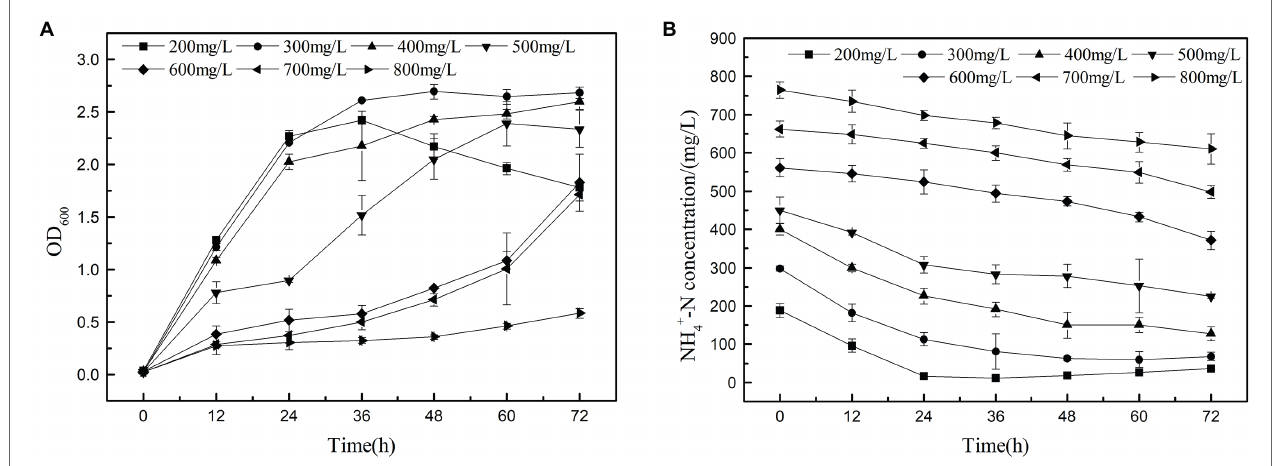
FIGURE 8 | Nitrification performance of strain K17 cultured under different ammonia nitrogen conditions. The initial ammonia nitrogen concentration was 200, 300, 400, 500, 600, 700 and 800 mg/l. The mixture was cultured at 165 rpm and 30 ° C for 12 h. (A) Growth characteristics of strain K17 under different ammonia nitrogen concentrations. (B) Ammonia nitrogen removal characteristics of strain K17 under different ammonia nitrogen